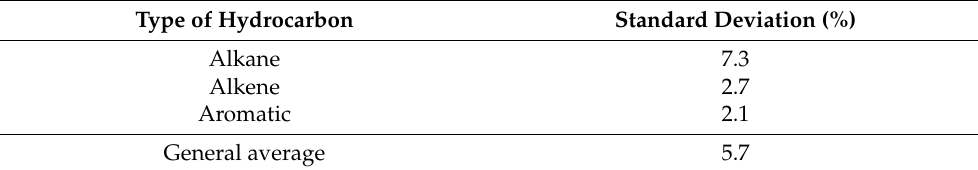
Table 5. Standard deviation calculated for some types of hydrocarbons detected in the pyrolysis